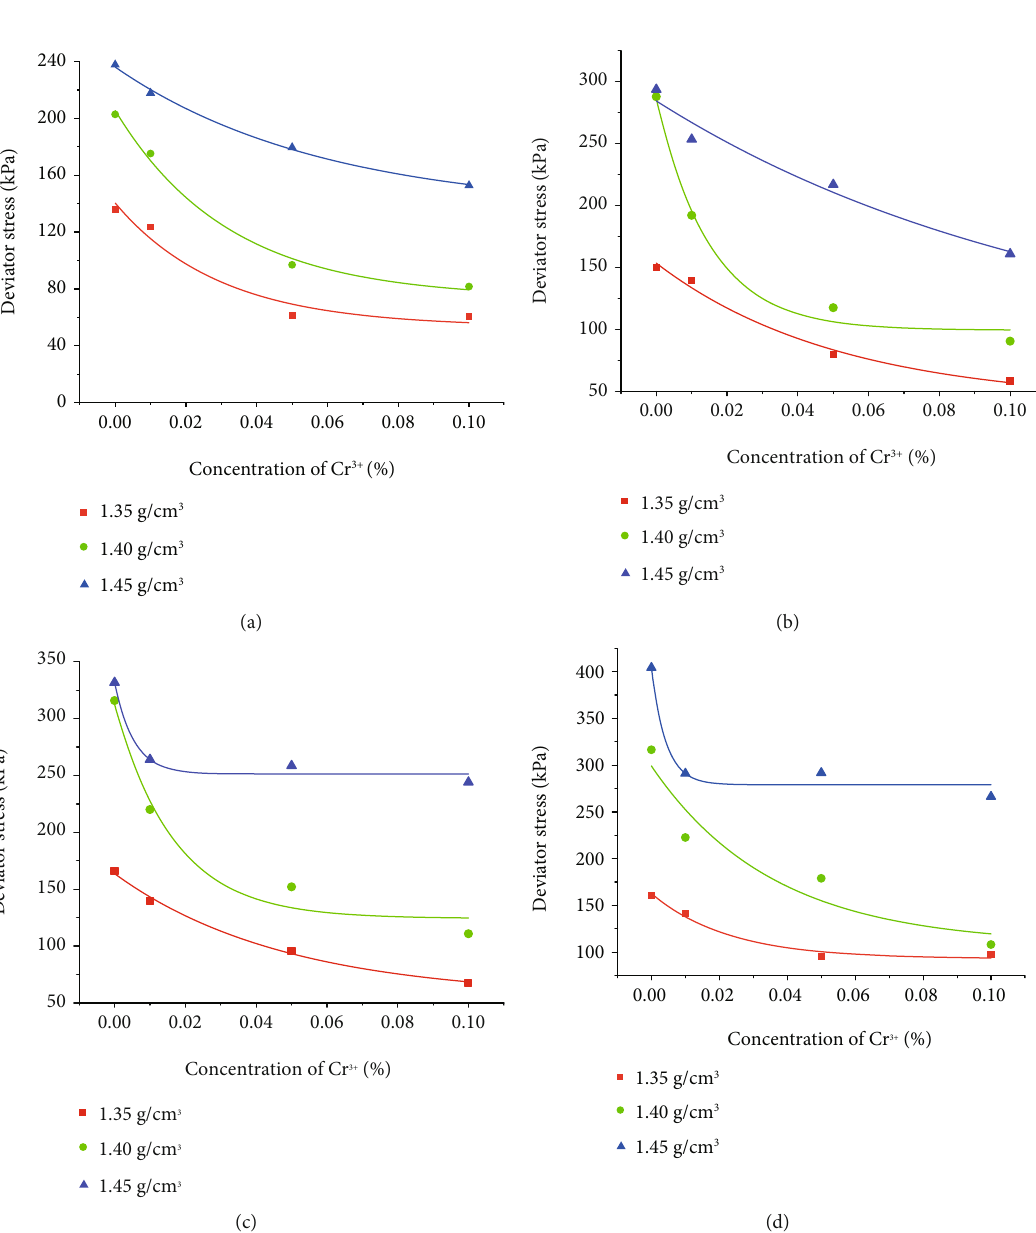
Figure 5: The relationship between initial dry density and deviatoric stress. (a) Con fi ning pressure 100kPa. (b) Con fi ning pressure 200kPa. (c) Con fi ning pressure 300 kPa. (d) Con fi ning pressure